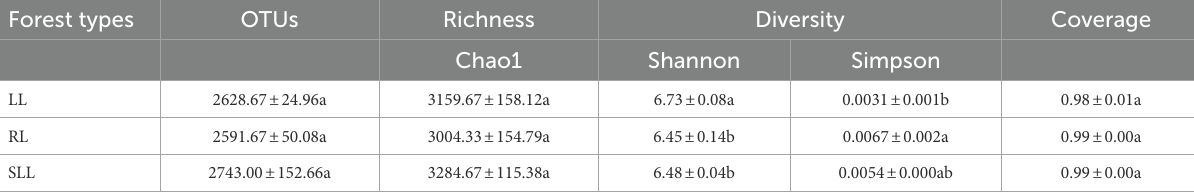
Values are the mean ± SD. Different lowercase letters behind the number indicate statistically significant difference among different types of larch forest. LL, Ledum palustre - Larix gmelinii forest; RL, Rhododendron dauricum - Larix gmelinii forest; SLL, Sphagnum-Bryum-Ledum palustre-Larix gmelinii